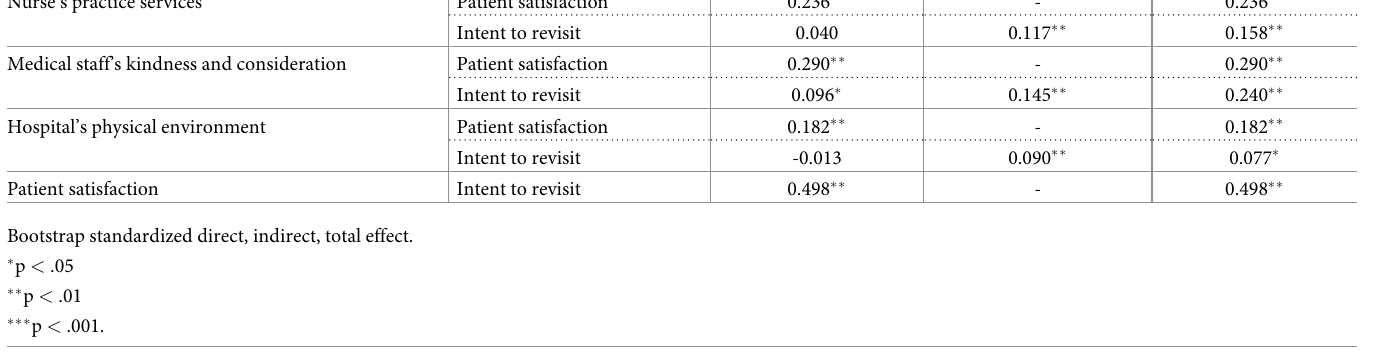
Table 5 shows the analysis results of total, direct, and indirect effects in the inpatient group. The values of the standardized direct effect on “patient satisfaction” were 0.223 for “physician’s practice service,” 0.236 for “nurse’s practice service,” 0.290 for “medical staff’s kindness and consideration,” and 0.182 for “hospital’s physical environment,” which were statistically signif- icant. The values of the standardized direct effect on “intent to revisit” were 0.191 for “physi- cian’s practice service,” 0.040 for “nurse’s practice service,” 0.096 for “medical staff’s kindness and consideration,” -0.013 for “hospital’s physical environment,” and 0.498 for “patient satis- faction” where the values for “physician’s practice service,” “medical staff’s kindness and con- sideration,” and “patient satisfaction” were statistically significant. The values of the standardized indirect effect of the independent variable on the dependent variable through the